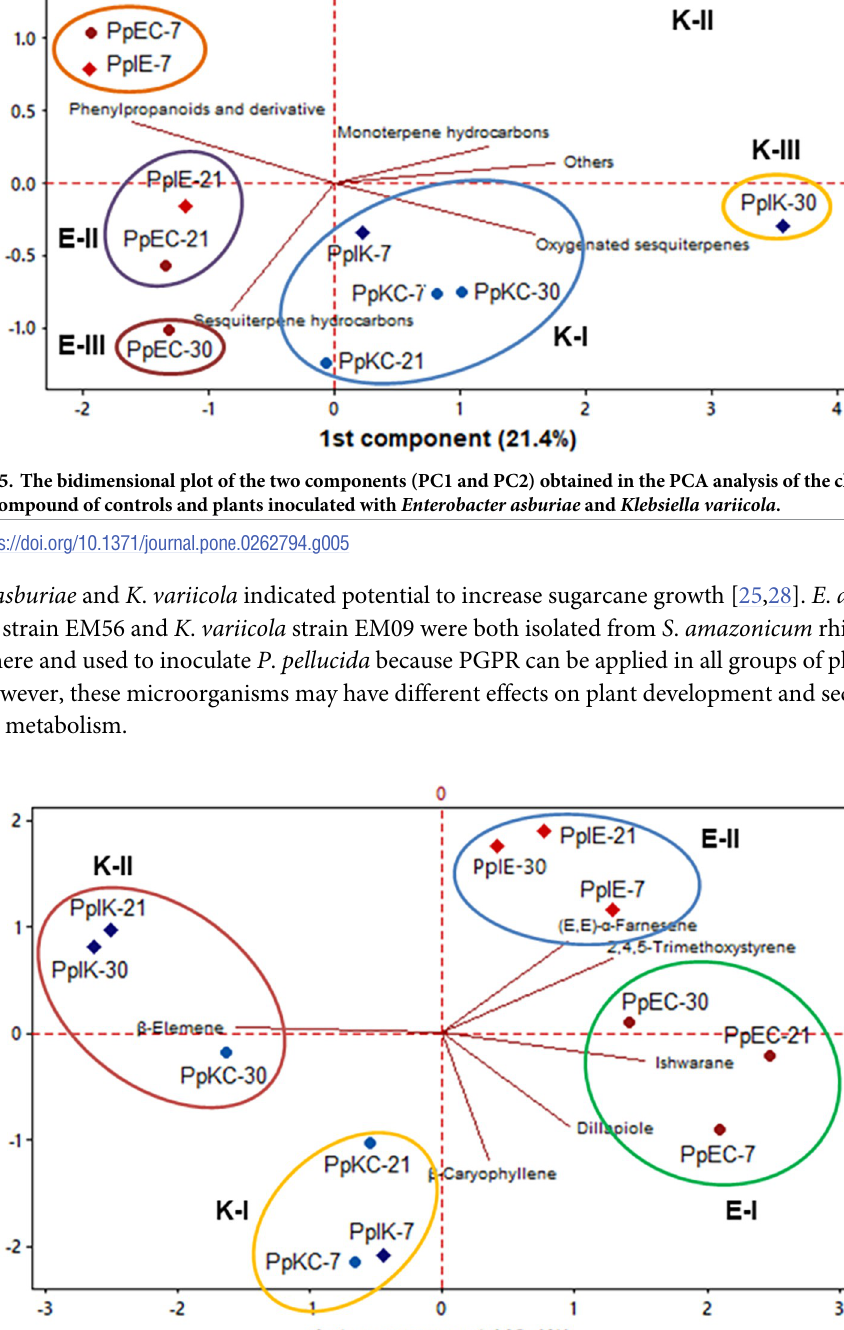
Fig 6. The bidimensional plot of the two components (PC1 and PC2) obtained in the PCA analysis of the compounds of controls and plants inoculated with Enterobacter asburiae and Klebsiella variicola .